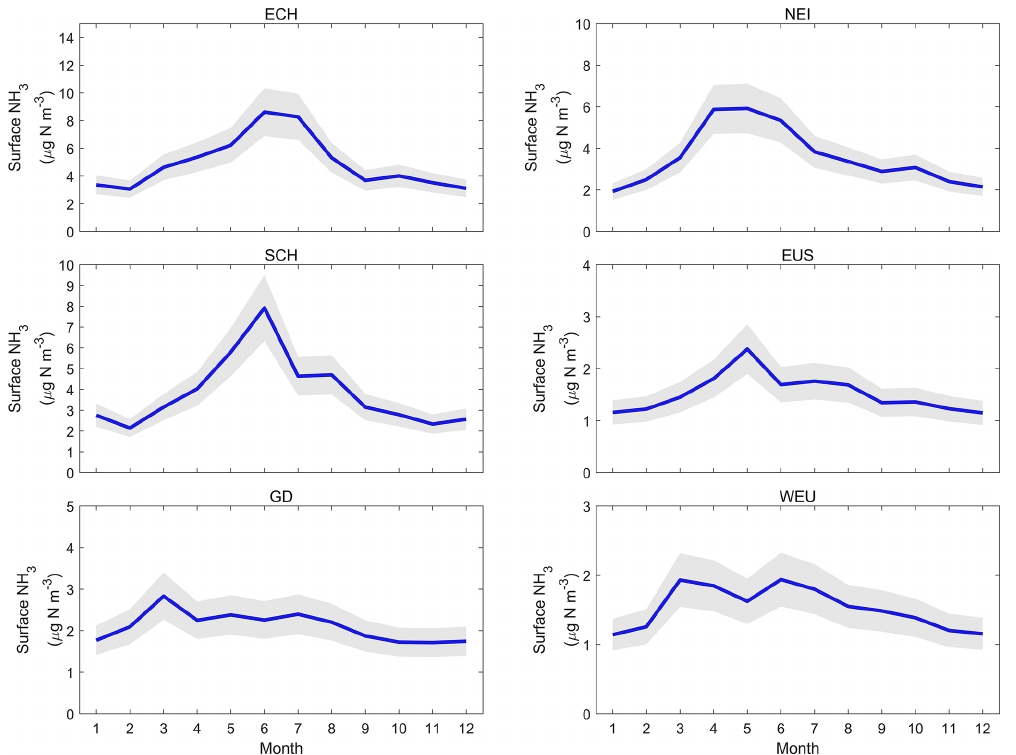
Figure 7. Monthly variations in surface NH 3 concentrations in hot spot regions including eastern China (ECH), Sichuan and Chongqing (SCH), Guangdong (GD), northeastern India (NEI), the eastern US (EUS), and western Europe